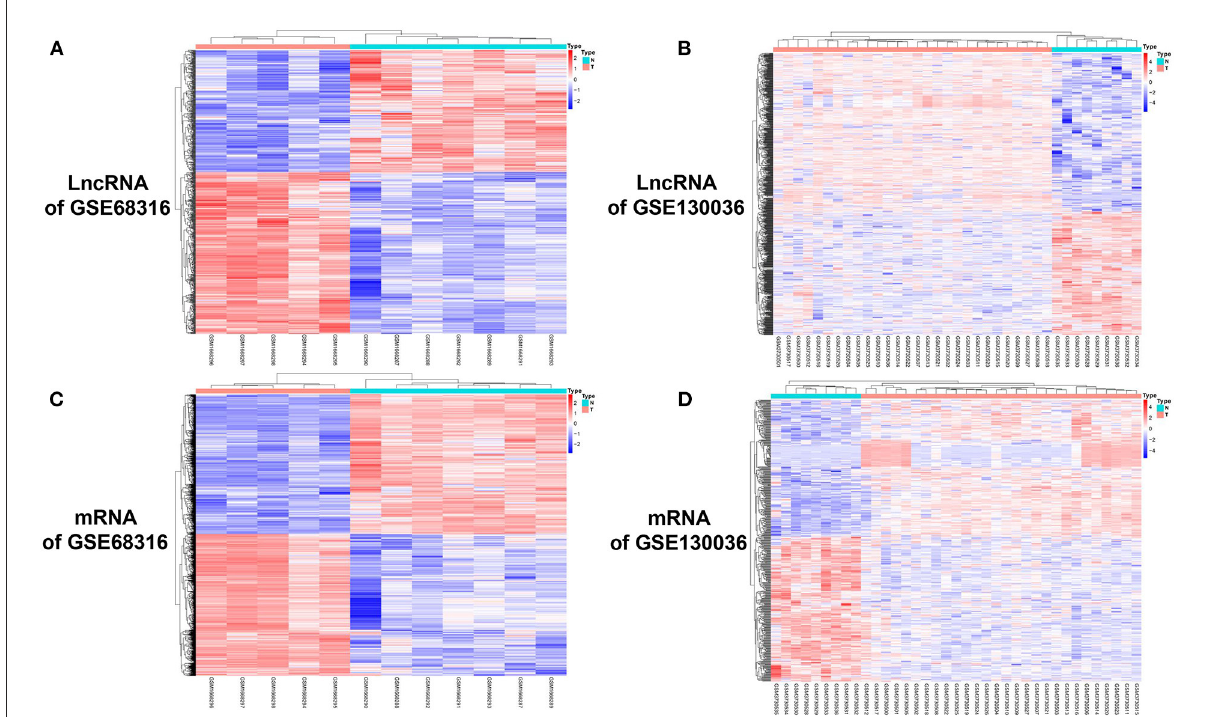
FIGURE2 A cluster heat map of differentially expressed lncRNAs and mRNAs between HCM patients and the controls. (A) A heat map of differentially expressed lncRNAs in the GSE68316 dataset. (B) A heat map of differentially expressed lncRNAs in the GSE130036 dataset. (C) A heat map of differentially expressed mRNAs in the GSE68316 dataset. (D) A heat map of differentially expressed mRNAs in the GSE130036 dataset. The gradient color change from blue to red represents the changing process from downregulation to upregulation.